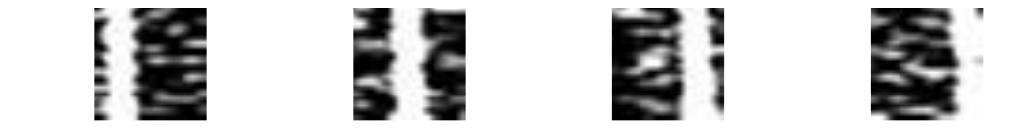
Figure 22. Partial 20 × 20 sample graph with target under the condition of 12 dB SNR.